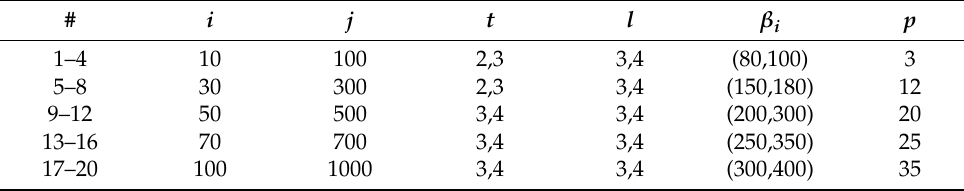
Table 5. Parameter values for the test instances